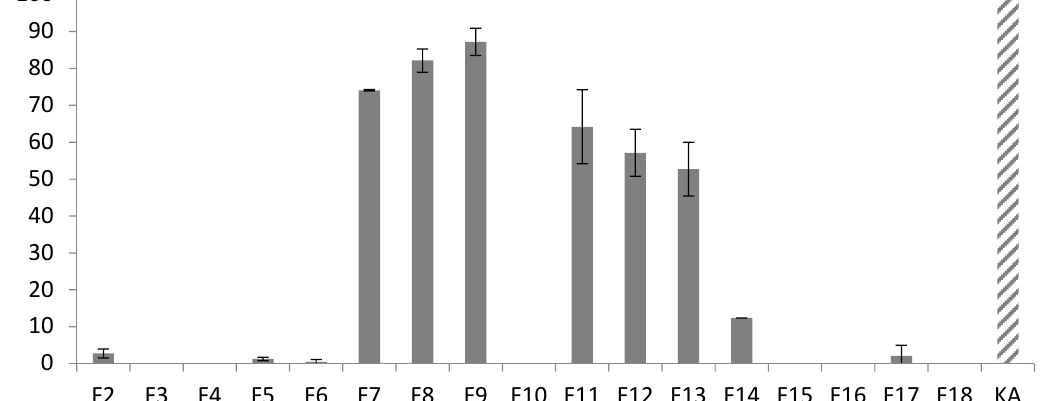
Figure 3. Whitening activity of R. luteola fractions F2 to F18 obtained by Centrifugal Partition Chromatography (CPC) fractionation of the sub-sample RL3-Methanol (mean whitening activity ± SD on 2 independent tyrosinase assays; KA: kojic acid, inhibition control).